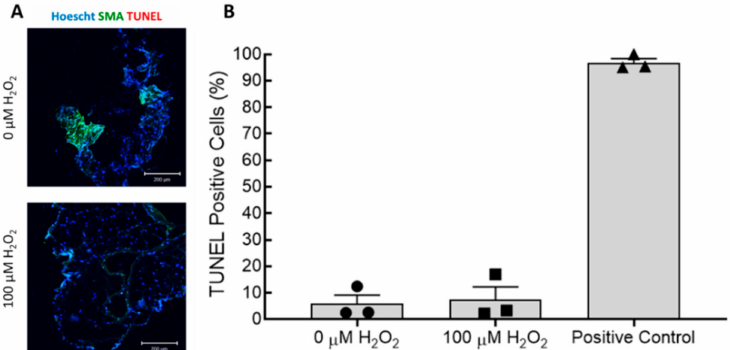
Figure 6. TUNEL staining confirmed that seven-day treatment of TEBVs with 100 µ M H 2 O 2 did not cause apoptosis (As in Figure 4, treatment began after maturation of TEBVs for seven days under flow). ( A ) TEBV cross-sections were stained for α -SMA and DNA strand breaks (TUNEL stain). There was no observable di ff erence in the degree of apoptosis between TEBVs treated with 100 µ M H 2 O 2 and controls. Scale bars represent 200 µ m. ( B ) Quantification of immunofluorescence showed that there was no significant increase in the number of TUNEL positive (apoptotic) cells in TEBVs treated with 100 µ M H 2 O 2 . Bars represent mean ±